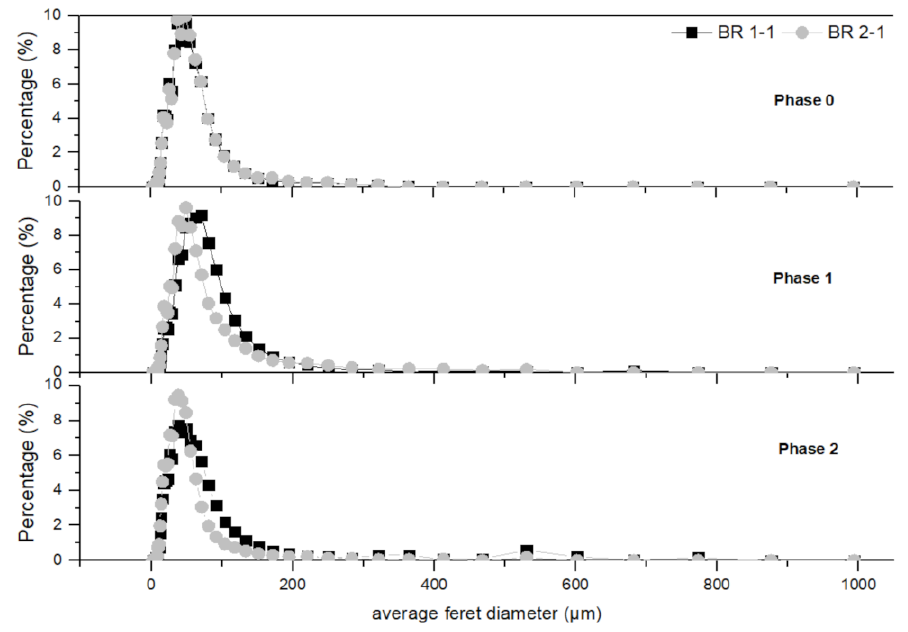
Figure 10. Average Feret diameter of activated sludge particles in B 1-1 (L-1) and B 2-1 (L-2) during the three phases of the